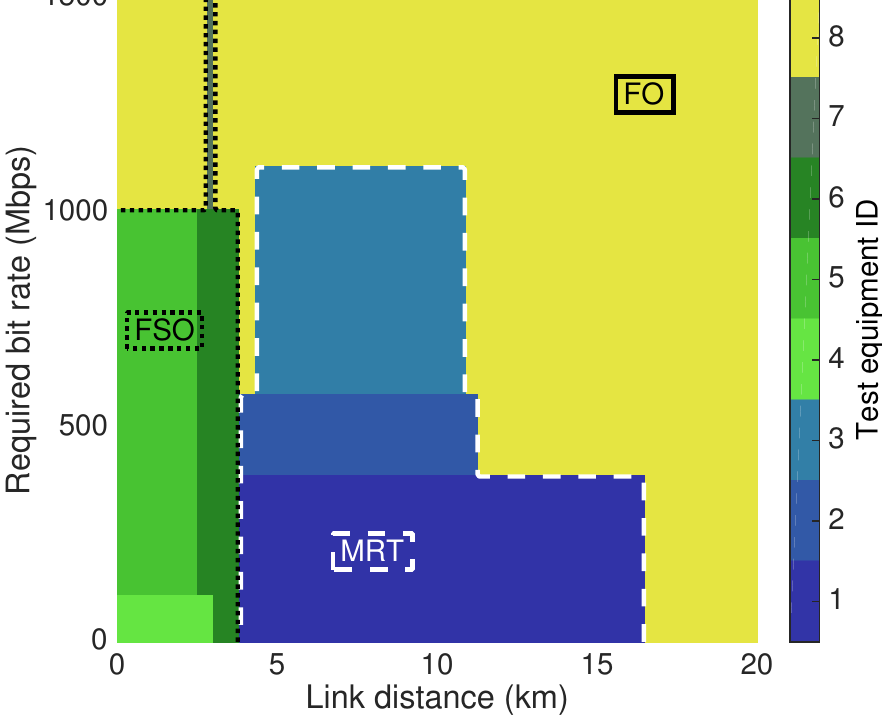
Figure 4. Cost-effective solutions for